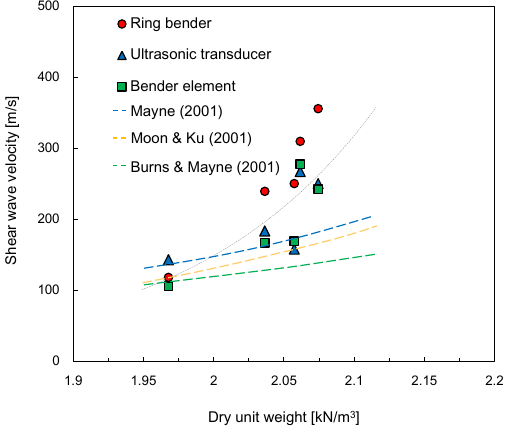
Figure 13. Relationship between dry unit weight and shear wave velocity. Table 3. Constants for the relationship between shear wave velocity and dry unit